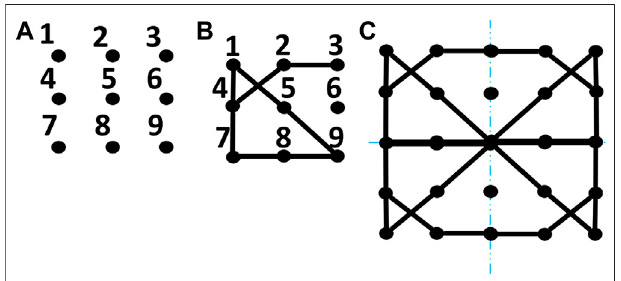
FIGURE 1 | (A) Representative volume element (RVE), (B) quarter of the cellular structure design formed using the RVE and (C) complete cellular structureformed bymirroring the RVEin horizontal and vertical axis (top